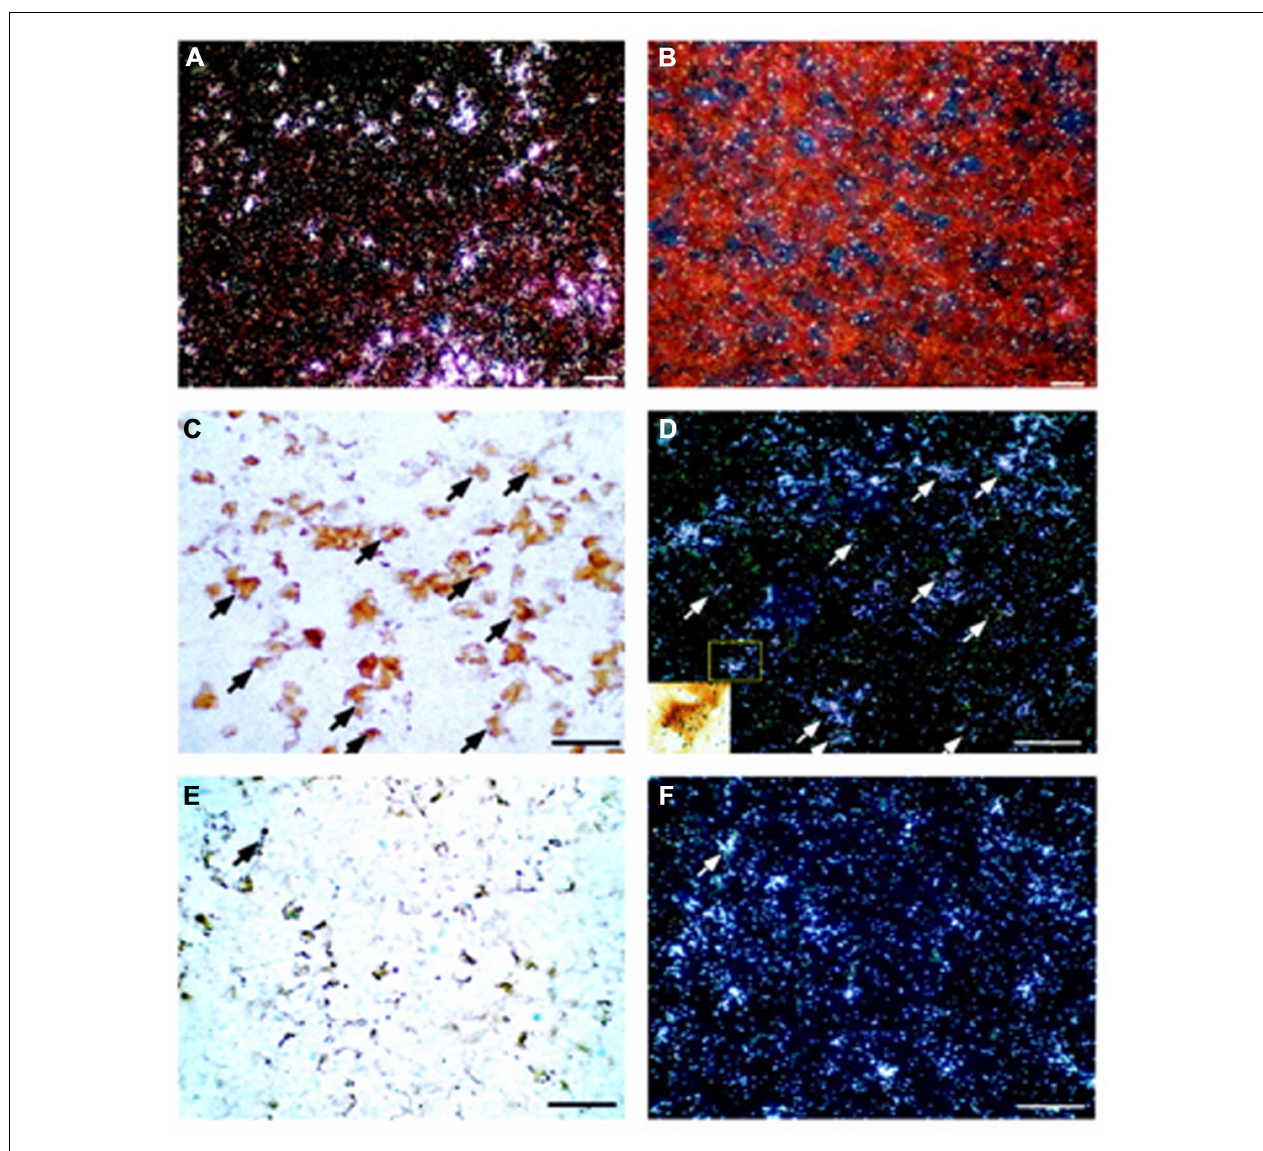
FIGURE 1 | Localization of CRF 2 receptor mRNA in the rat anterior pituitary gland. Representative dark-field photomicrographs showing anterior pituitary sections probed with either antisense (A) or sense (B) in situ hybridization probes for CRF 2 receptor mRNA. Positive signals (indicated by silver grain clusters ) were found only in the tissues probed with antisense probes; no signals were found in the sense control. (C) Bright-field photomicrograph showing LH-immunoreactive cells in the rat anterior pituitary. Gonadotrophs (visualized by the brown DAB precipitate) represent LH-immunoreactive cells. (D) Dark-field image of the same area as panel (C) showing CRF 2 receptor mRNA-positive cells ( silver grain clusters ). Some of the cells that are double-labeled by